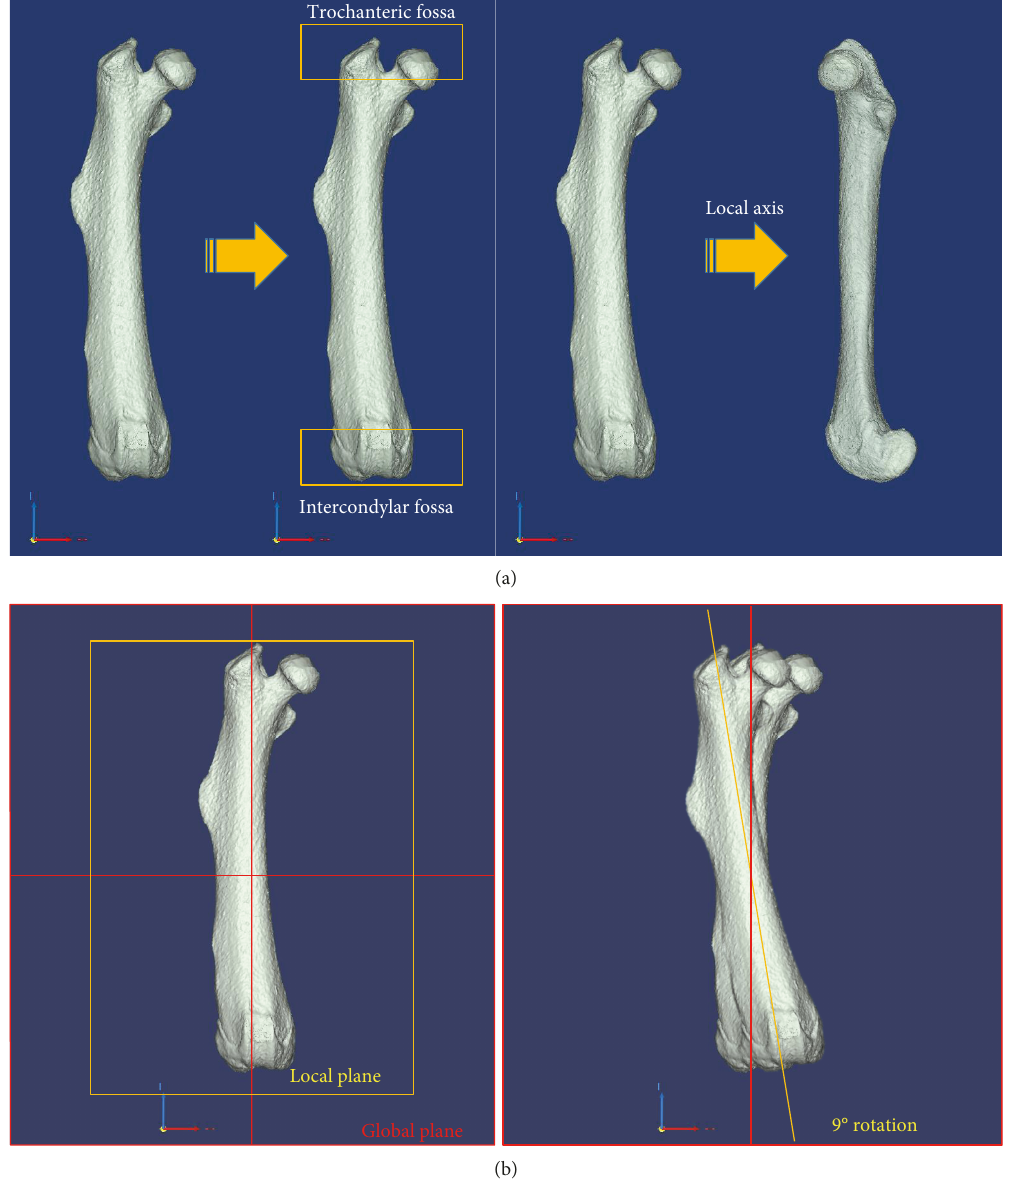
Figure 5: The schematic illustrations of the rearrangement of a femur for fi nite element analysis. (a) The local z -axis was aligned with the global Z -axis. (b) The local x-z plane was aligned with the global X-Z plane, and the femur was rotated 9 ° in the global X-Z